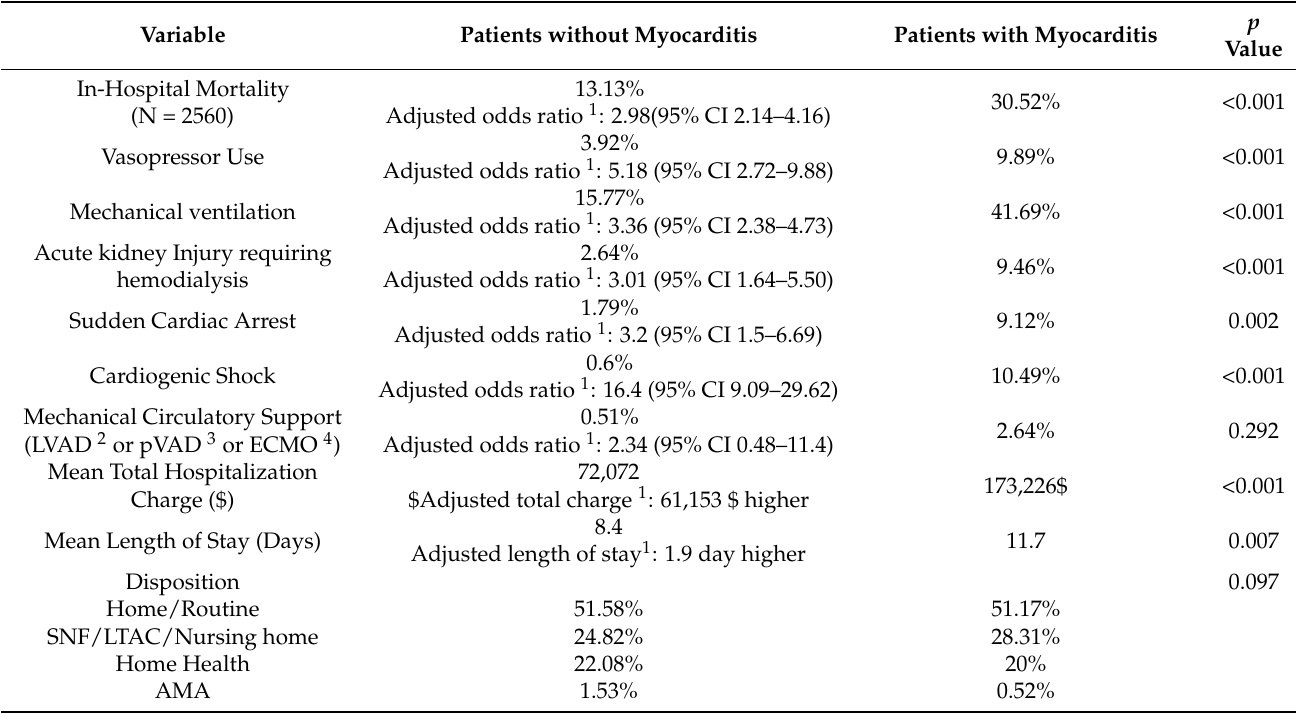
Table 3. In-hospital Outcomes for 1:1 PS Matched